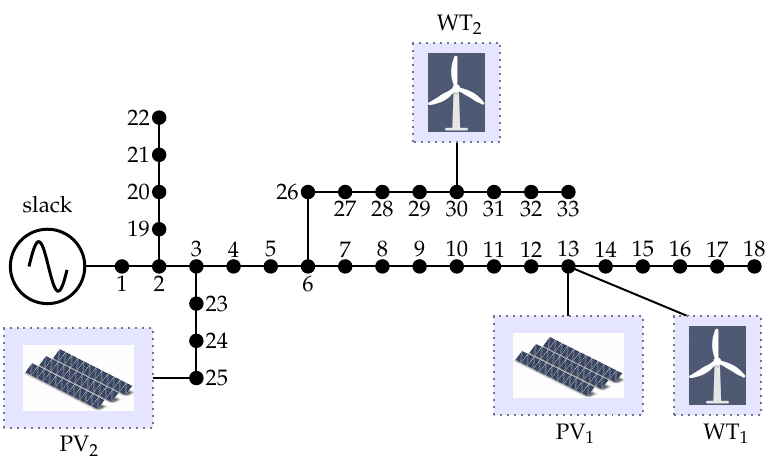
Figure 1. IEEE 33-node system with renewable generation. The data of the daily demand curves and solar and wind generation profiles are outlined in Table 2 and were retrieved from [8]. The renewable generation sources have the following peak values retrieved from